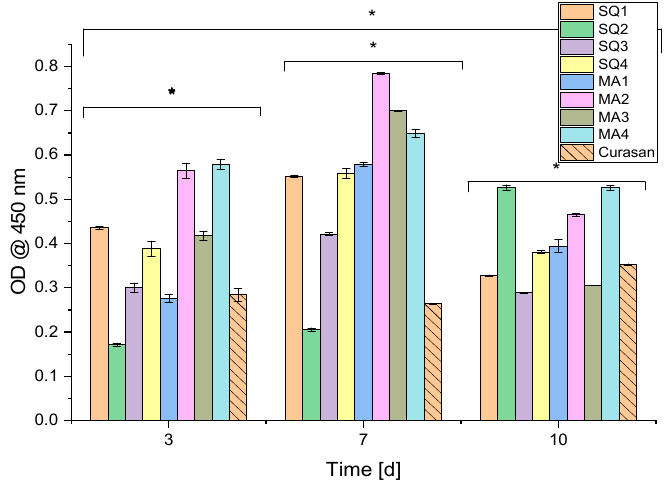
Figure 12. Cell proliferation assay (WST-I): results of the cells on the scaffolds; n = 30; with p < 0.05 [*]. All samples examined showed a cytotoxicity of 0%. Figure 13 clearly shows that all curves in the cells-only (negative control) range are at 0% and partly below, in contrast to the positive control (TritonX (TX)).